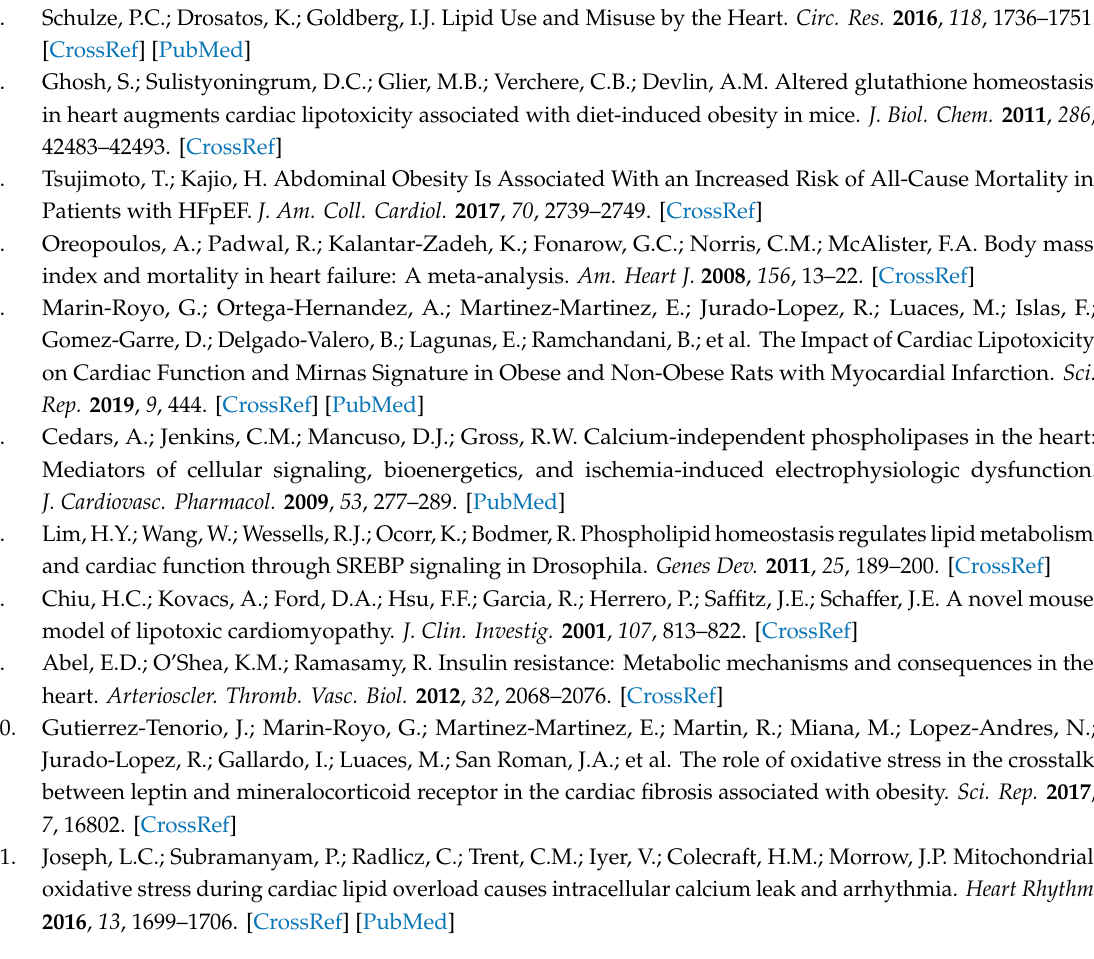
Figure S1: E ff ects of the mitochondrial antioxidant MitoQ (MQ) on mitochondrial superoxide anion levels. Figure S2. Impact of the mitochondrial antioxidant MiToQ on mitochondrial lipid species and protein levels in heart of obese rats. Figure S3. E ff ects of antioxidant MiToQ on complexes protein levels in palmitic-acid-treated H9c2